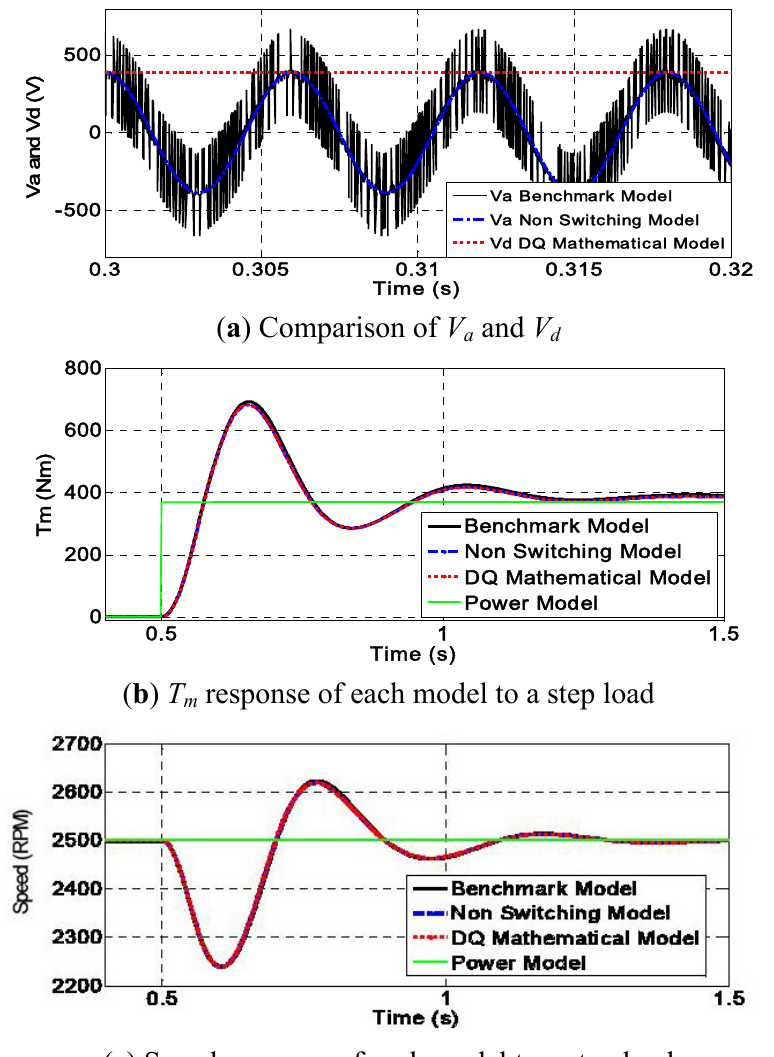
Figure 8. Simulation results: ( a ) Comparison of V to a step load; ( c ) Speed response of each model to a step